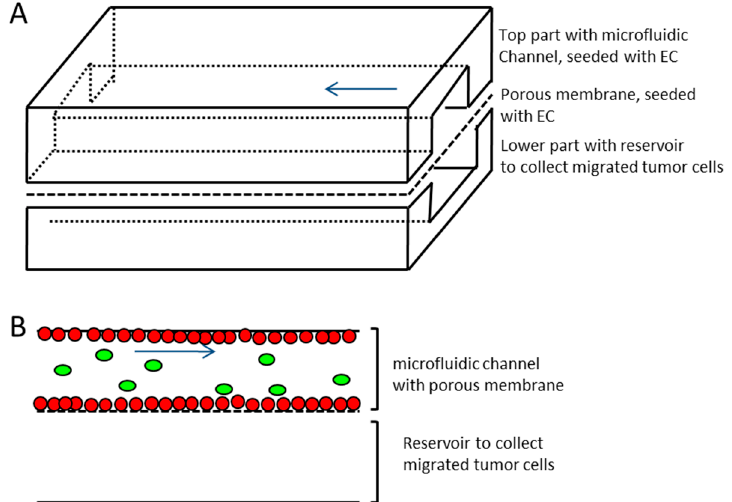
Figure 2. Schematic representation of the microfluidic device. ( A ) Upper and lower channel made of Polydimethylsiloxane (PDMS) with porous membrane (pore size 5 µm) sandwiched in between. The upper channel with membrane represents the vessel equivalent (channel dimensions 500 µm × 100 µm × 5.9 cm, width x height × length, respectively) and is seeded with endothelial cells (EC), the lower channel represents reservoir for transmigrating tumor cells (lower channel dimensions 1 mm × 1 mm × 5.9 cm, width x height × length, respectively). ( B ) Side view sketch of microfluidic channels and membrane separating the two channels. Red dots—endothelial cells growing on all sides of the upper channel and on the membrane; green ovals—tumor cells introduced to vessel equivalent; blue arrow—direction of flow.